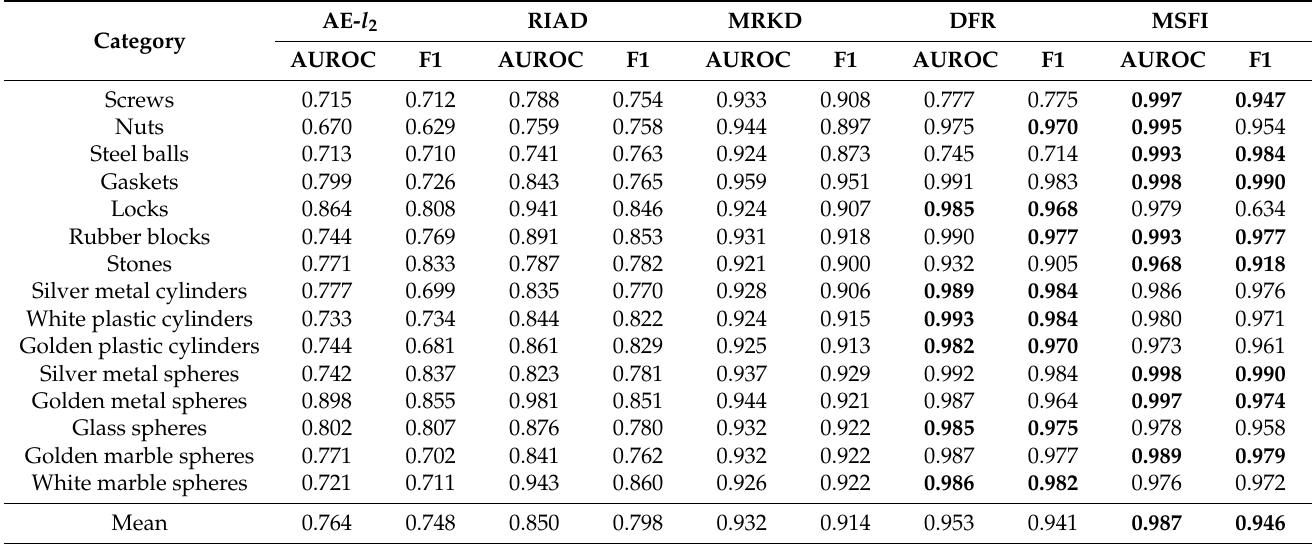
Table 2. The anomaly detection results on FOD dataset. The best result for each class is